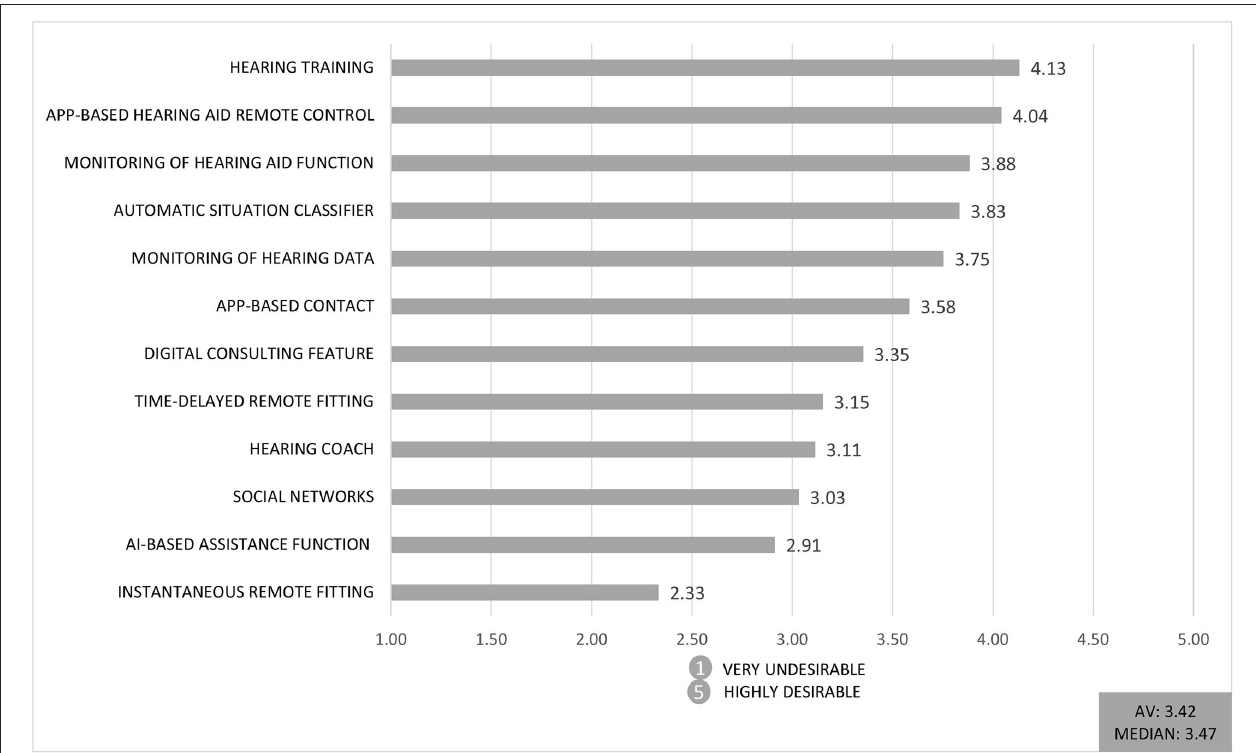
FIGURE 4 | Mean response to the question “To what extent do you wish to offer the digital service within the next 5 years?” (1 = very undesirable to 5 = highly desirable; AV =